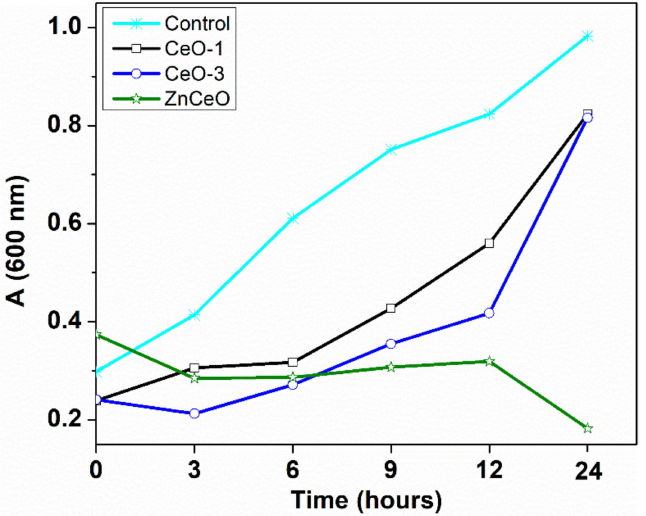
Figure 10. Dynamic growth curves for Staphylococcus aureus treated with cerium oxide nanoparticles.